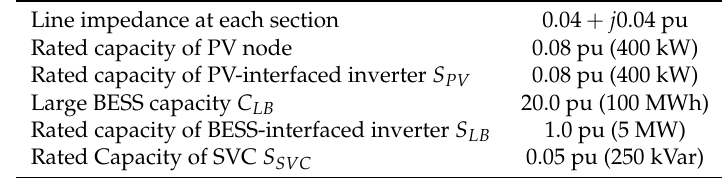
Table 1. Parameters of the distribution